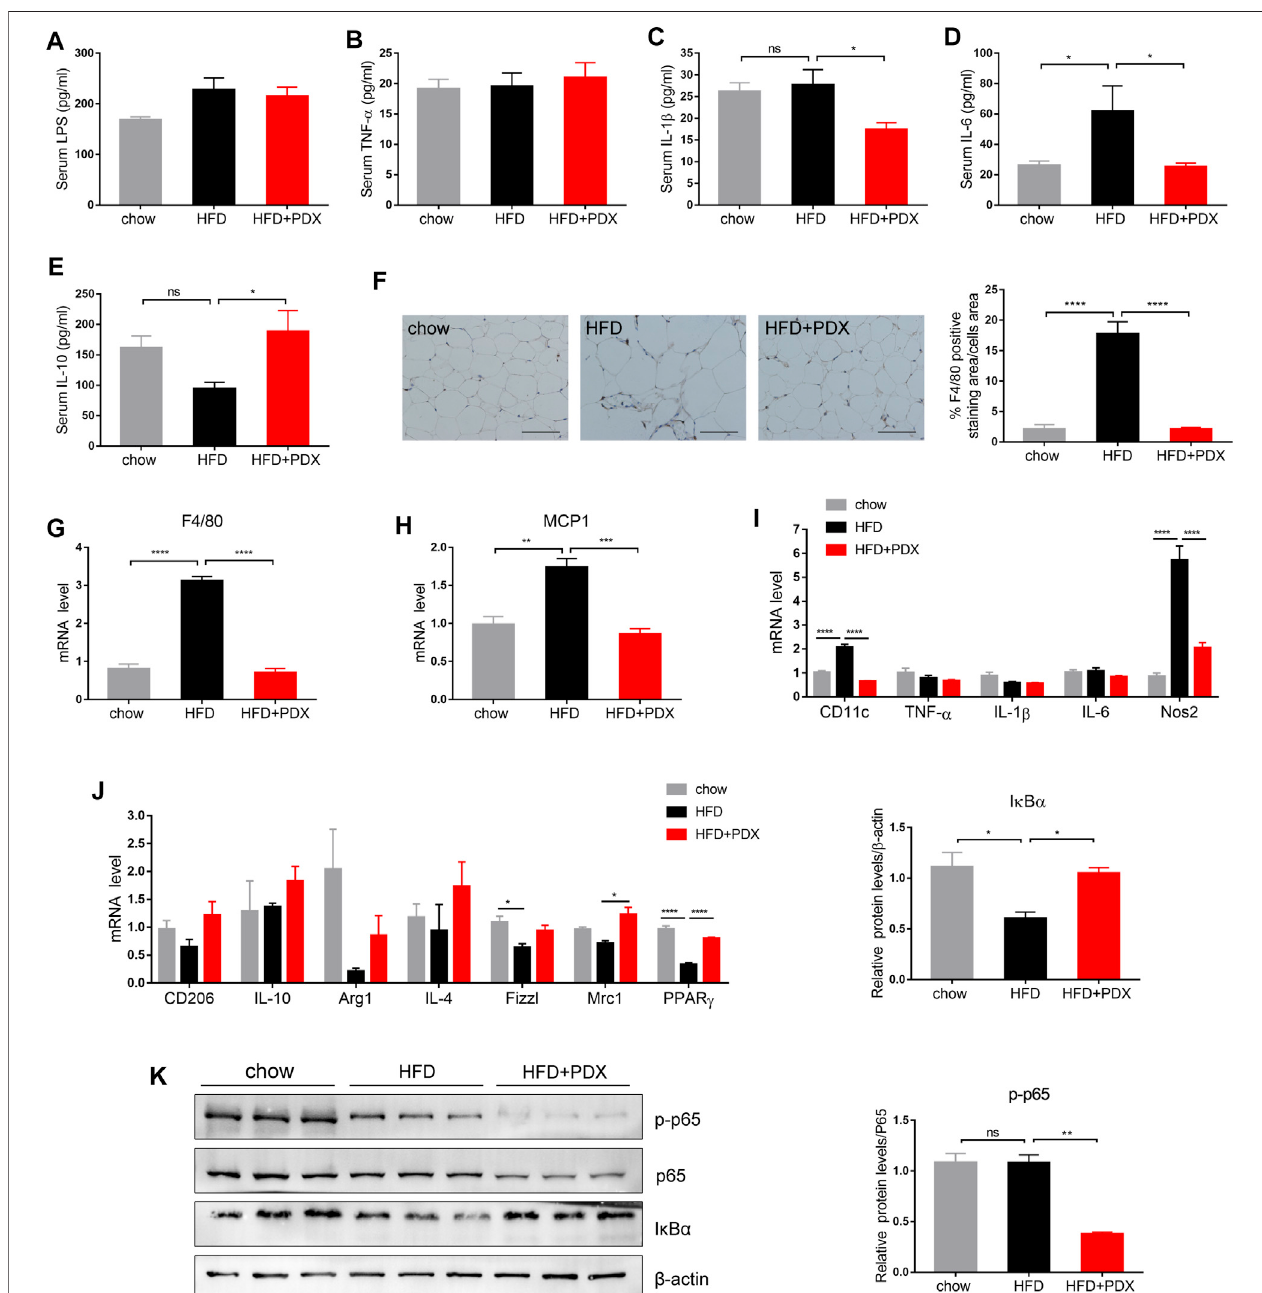
FIGURE 4 | PDX maintained a lower in fl ammation level and promoted M2 macrophage polarization in the adipose tissue of HFD-fed mice (Part 1). (A) Serum LPS. (B) Serum TNF- α (B) . (C) Serum IL-1 β . (D) Serum IL-6. (E) Serum IL-10. (F) Representative images of immunohistochemical staining of epididymal adipose tissue against the speci fi c macrophage maker F4/80 and the quanti fi cation of F4/80-positive staining area. Scale bar, 100 μ m; magni fi cation, x200. (G) qPCR analysis of the mRNA levels of F4/80 in epididymal adipose tissue. (H) qPCR analysis of the mRNA levels of MCP1 in epididymal adipose tissue. (I) qPCR analysis of the mRNA levels of M1 macrophage maker CD11c, TNF- α , IL-1 β , IL-6 and Nos2 in epididymal adipose tissue. (J) qPCR analysis of the mRNA levels of M2 macrophage maker CD206,IL-10,Arg1,IL-4,Fizz1,Mrc1andPPAR γ inepididymal adiposetissue. (K) WesternblotanalysisoftheproteinsexpressioninvolvedinNF- κ Bsignalingpathway in epididymal adipose tissue. n (cid:2) 12 (A – F) , n (cid:2) 4 (G – J) or n (cid:2) 3 (K) per group. * p < 0.05; ** p < 0.01; *** p < 0.001; **** p < 0.0001; ns, not statistically signi fi cant.